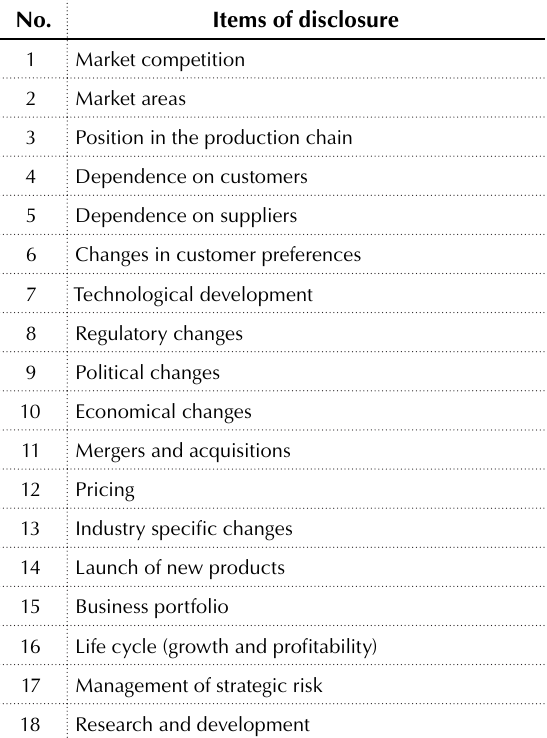
Table 4. Financial risks disclosure